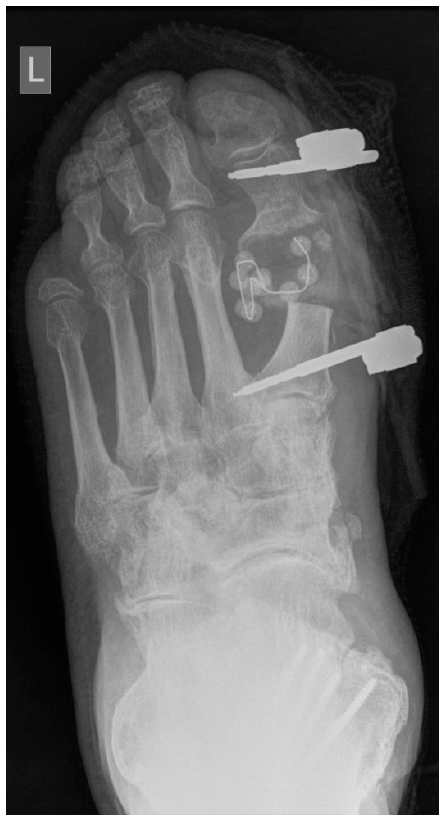
Figure 2. Segmental resection of the first MTP joint with a Septopal ® Chain.